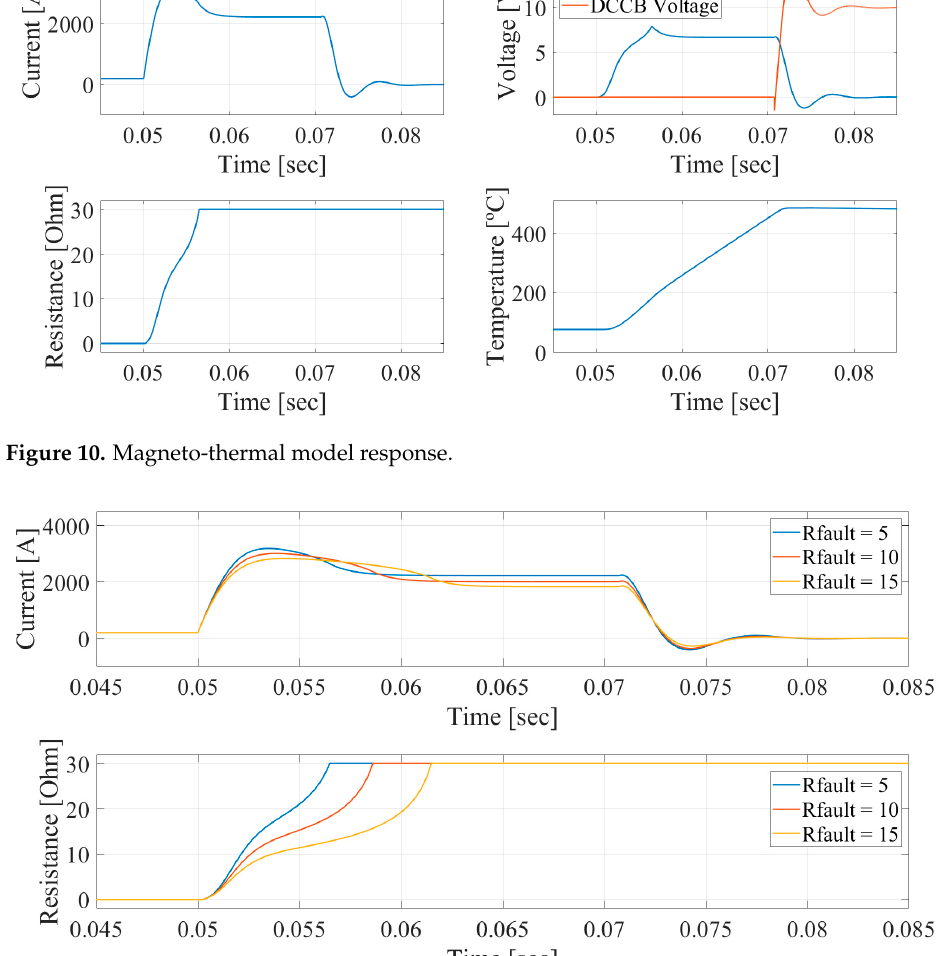
Figure 10. Magneto-thermal model response.